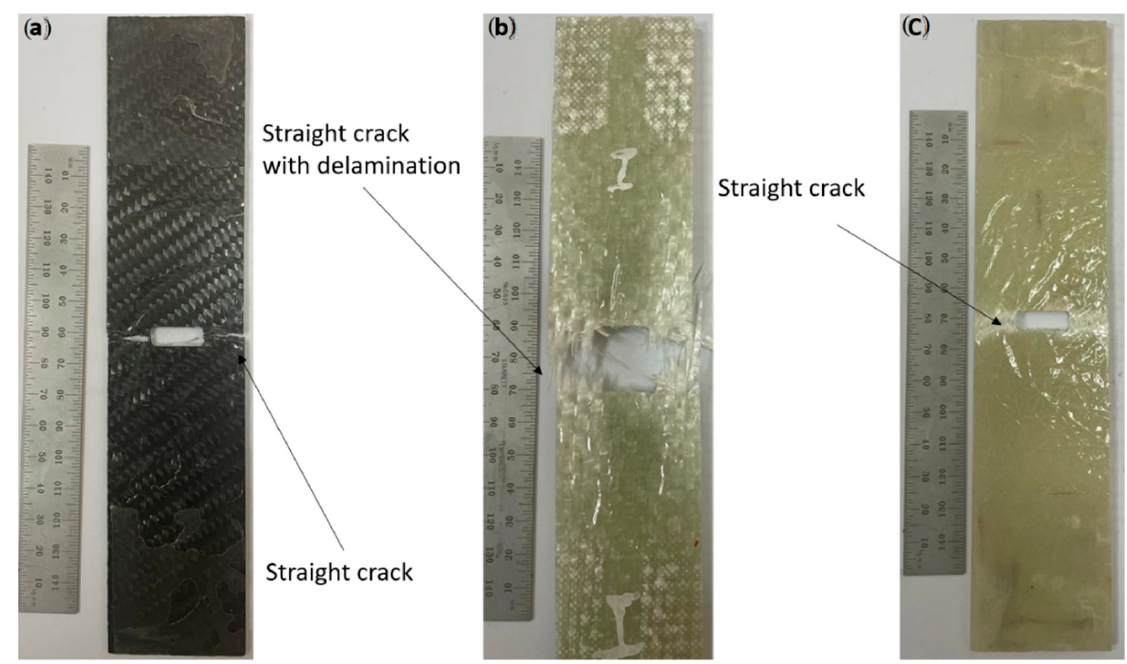
Figure 11. Modes of failure in CNT ( a ) CFRP, ( b ) GFRP-W and ( c ) GFRP-R.